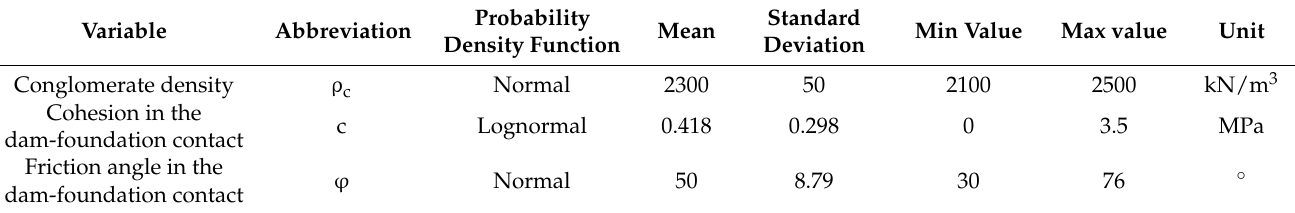
Table 3. Selected random